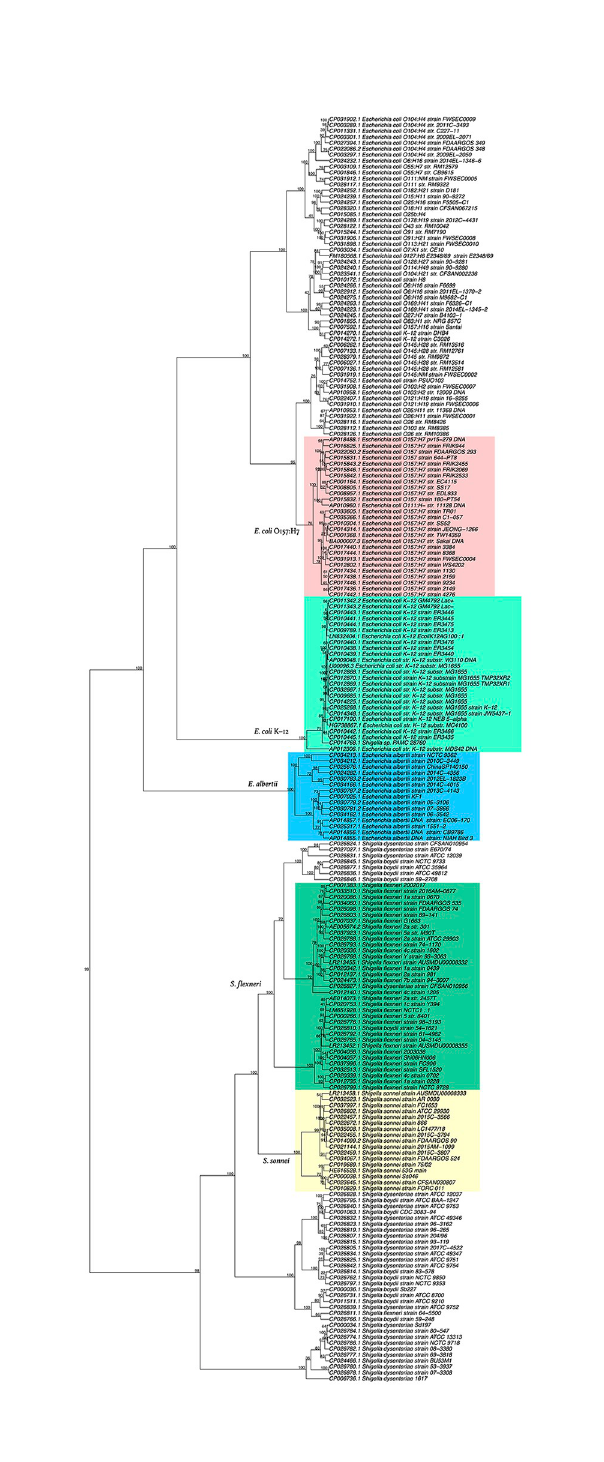
Fig 4. Phylogenetic trees of E. albertii , Shigella , and E. coli with serotype information based on their pentanucleotide frequencies. The numbers at the nodes indicate the percentage occurrences among 1,000 bootstrap values. Separated groups of species and serotypes are